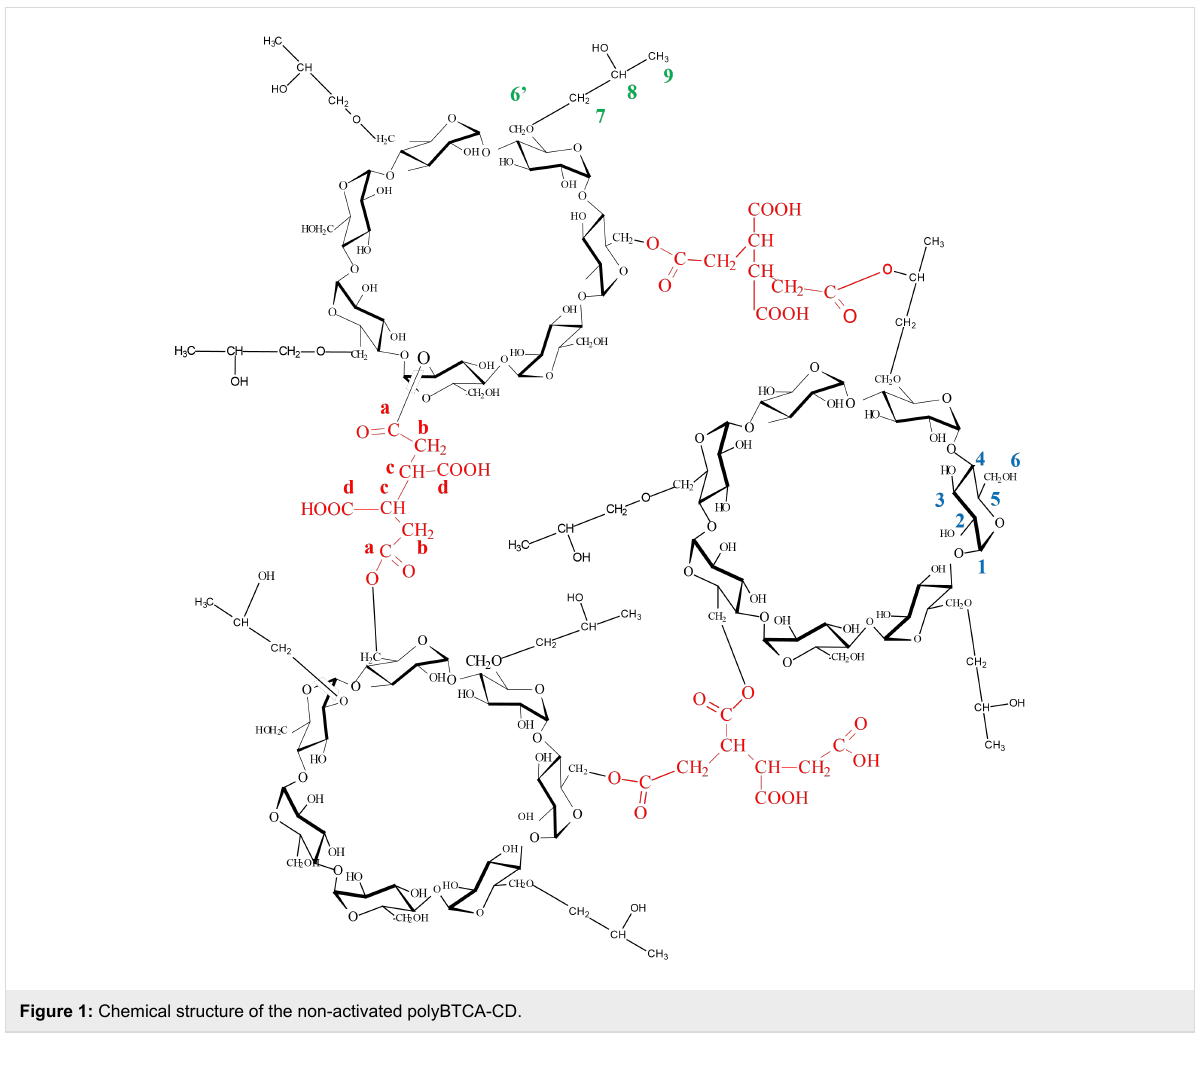
Figure 1: Chemical structure of the non-activated polyBTCA-CD.